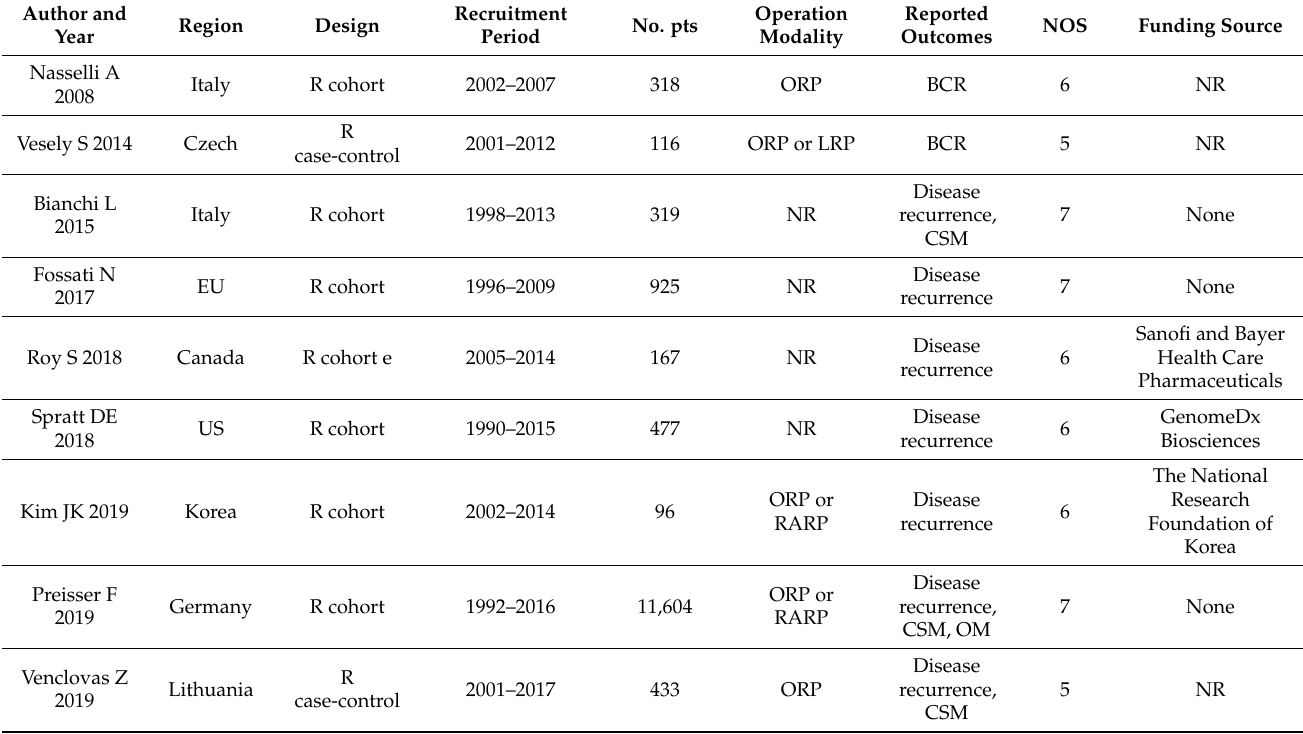
Table 1. Characteristics of eligible studies included in the systematic review.